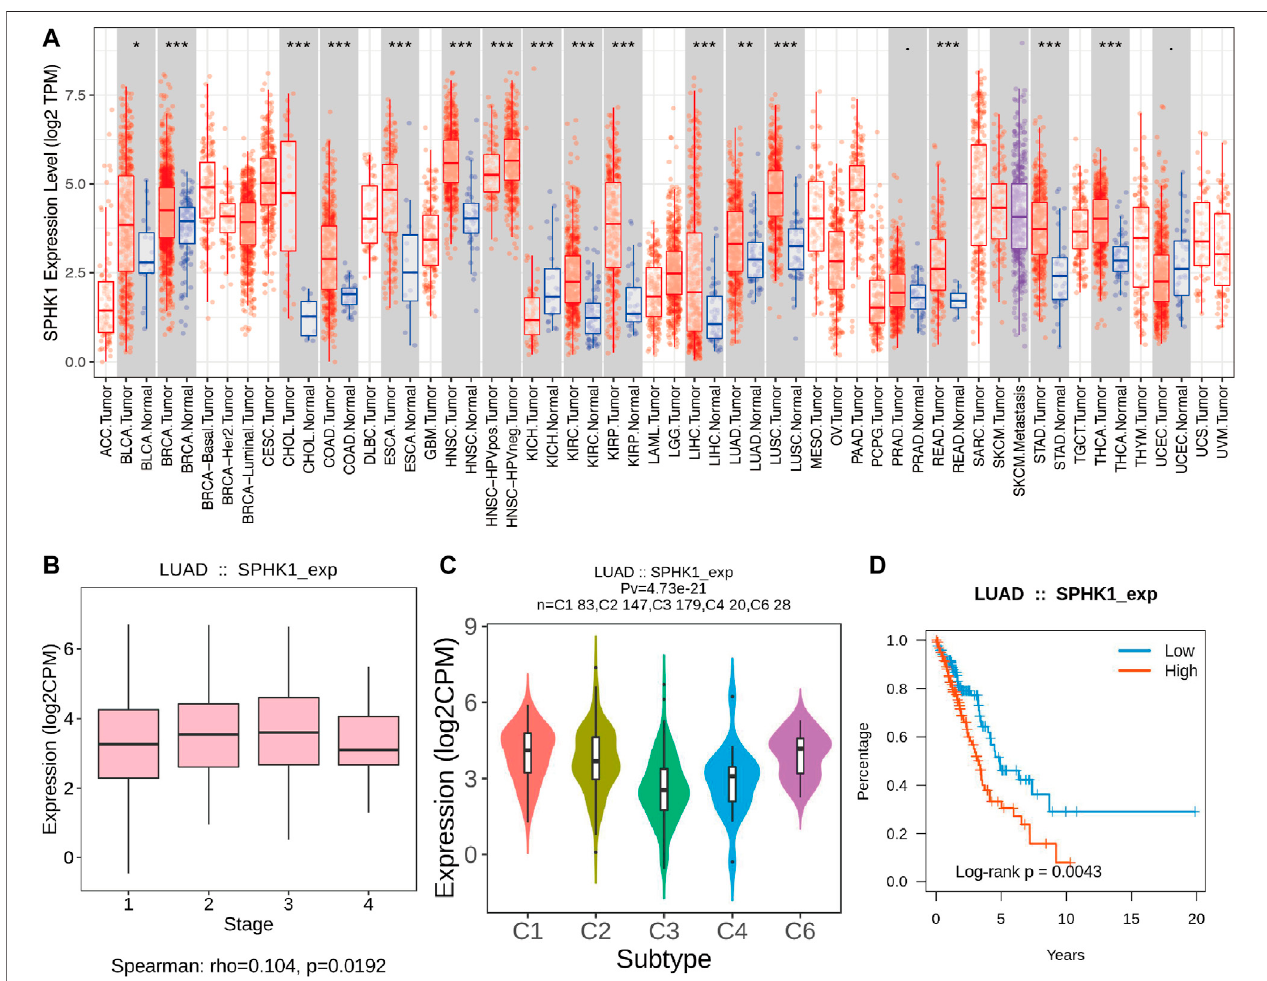
FIGURE 11 | Validation of SPHK1 expression level and its associationswith OS. (A) SPHK1 expression level in various cancers compared with normal tissues. (B) SPHK1 expression level in different stages of LUAD. (C) SPHK1 expression distribution across LUAD subtype. (D) Kaplan – Meier survival analysis by different SPHK1 expression level of LUAD. OS, overall survival; LUAD, lung